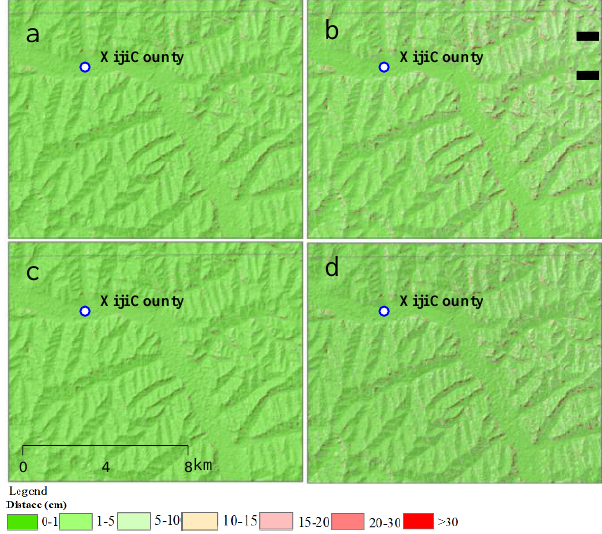
Figure 4. The distribution of the landslide movement distance (D N ) along the Haiyuan and Liupanshan Faults: The seismic magnitude of Ms 7.5 along the Haiyuan Fault ( a ), Ms 8.5 along the Haiyuan Fault ( b ), Ms 7.5 along the Liupanshan Fault ( c ), and Ms 8.5 along the Liupanshan Fault ( d ).